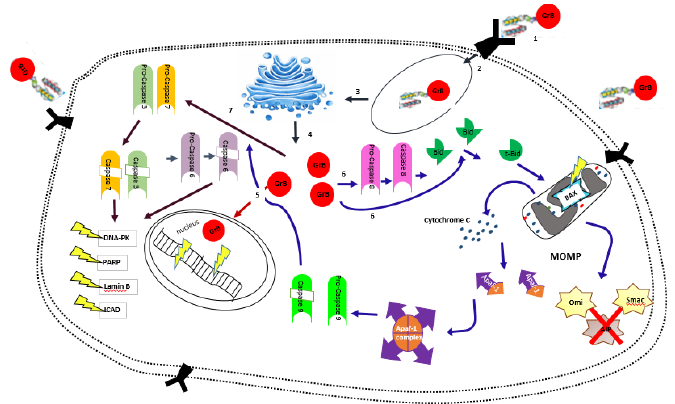
Figure 1. Mechanism of action for the targeted delivery of GrB to the tumor cell. (1) Binding of GrB hCFP to receptor on cell membrane; (2) Take up of hCFP into the cell; (3) Routing and processing in ER and Golgi leading to endosomal escape of GrB; (4) Active GrB released into the cytosol; (5) Direct cleavage of nuclear machinery; (6) Initiation of the mitochondrial/caspase independent pathway. GrB cleaves procaspase-8 leading to caspase-8 activation. Caspase-8 cleaves the BH3